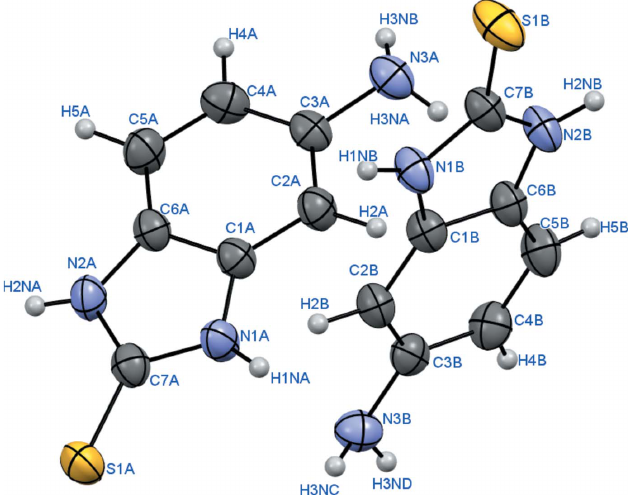
Figure 1 Molecular structures of molecules A and B showing the atom-labelling scheme. Displacement ellipsoids are drawn at the 50% probability level.